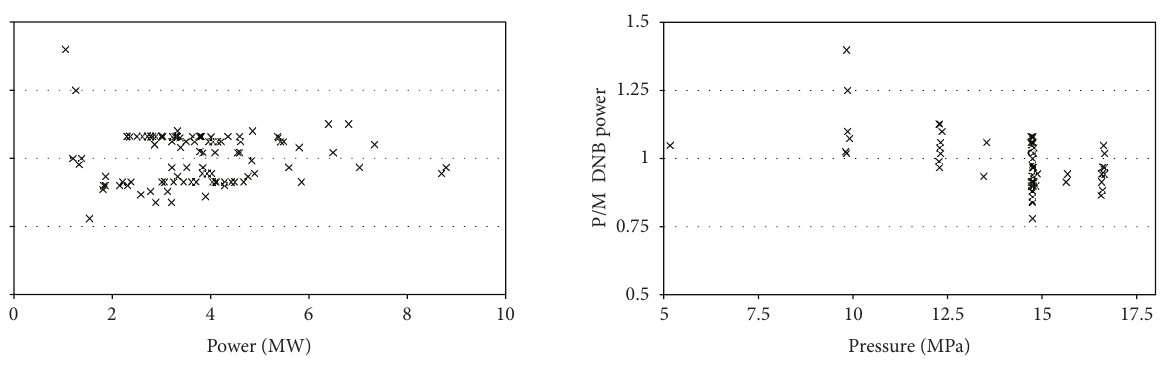
F 13: P/M DNB power versus pressure for assembly types A0, A2, A3, A4, and